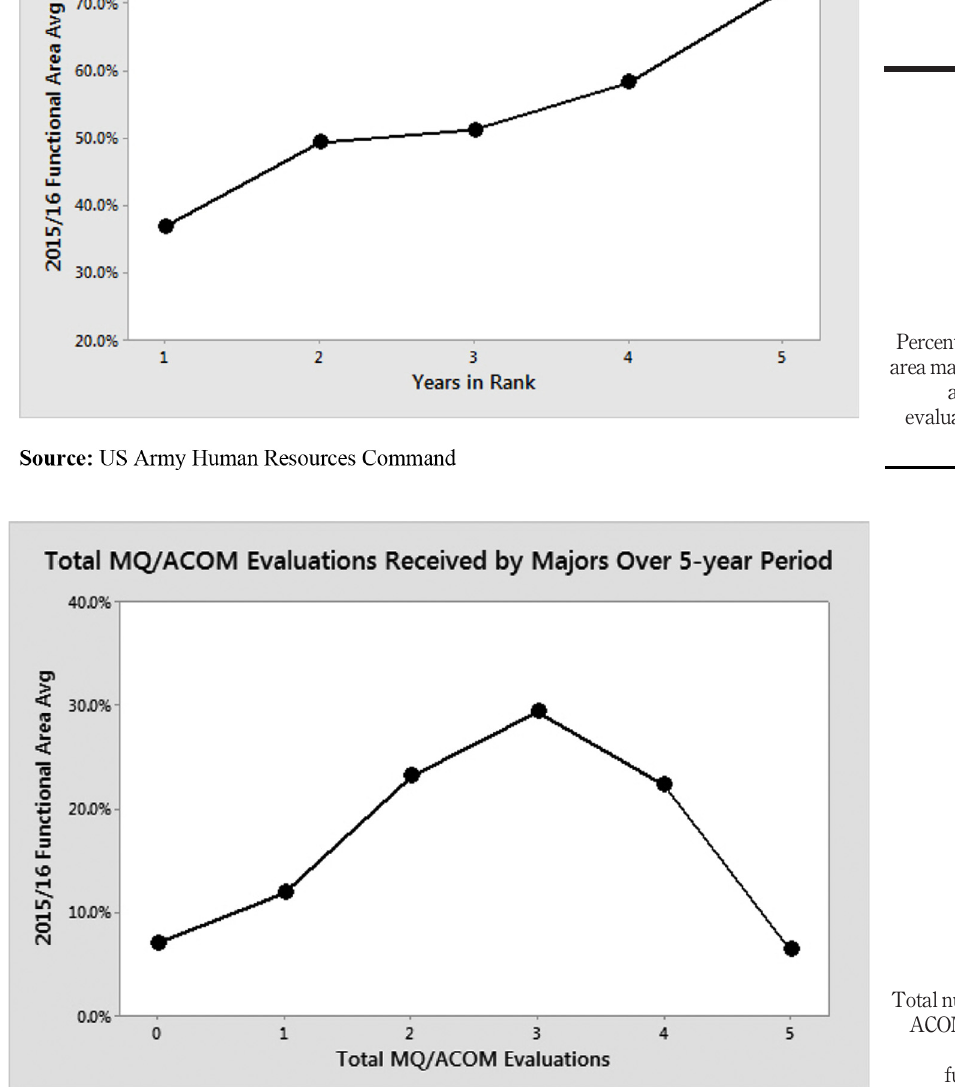
Figure 4. Total number of